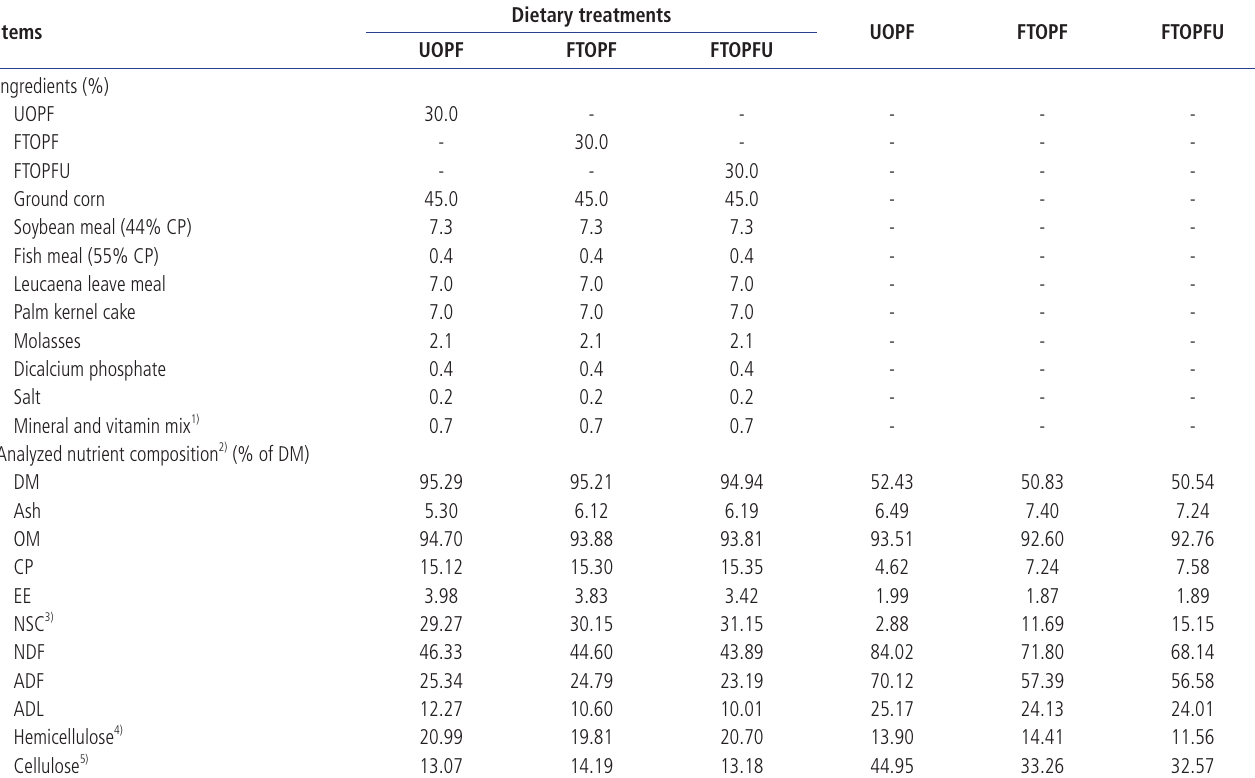
Dietary treatments